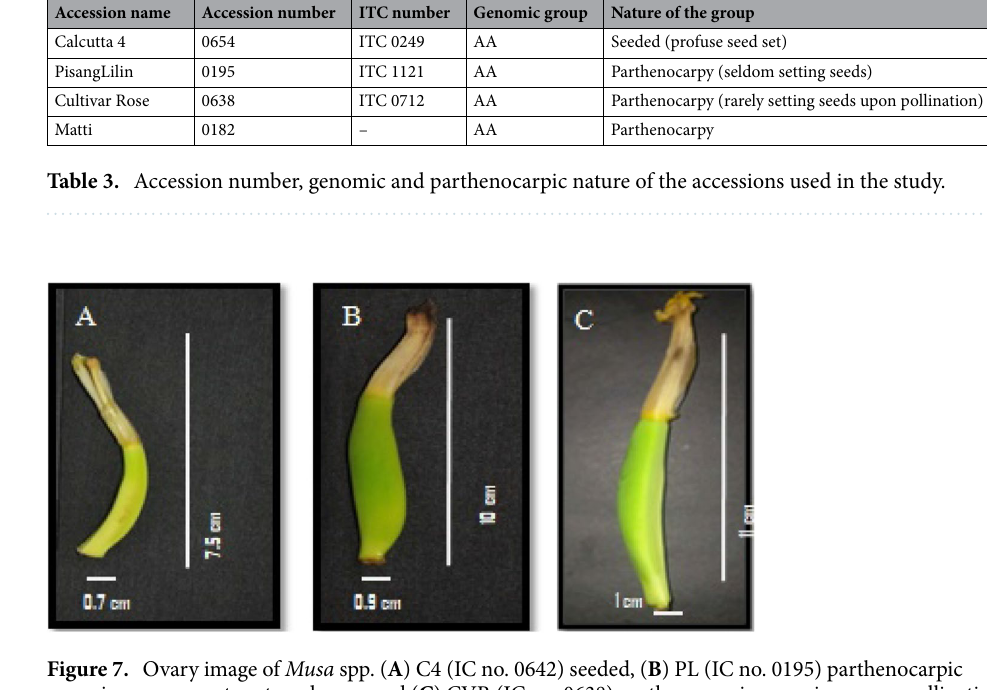
Figure 7. Ovary image of Musa spp. ( A ) C4 (IC no. 0642) seeded, ( B ) PL (IC no. 0195) parthenocarpic accession, very rare to set seed upon and ( C ) CVR (IC no. 0638) parthenocarpic accession, upon pollination seed set occurs